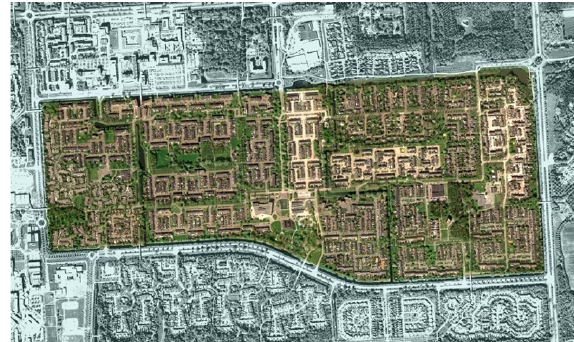
Figure 10. Atolwijk: aerial map. Source: authors.